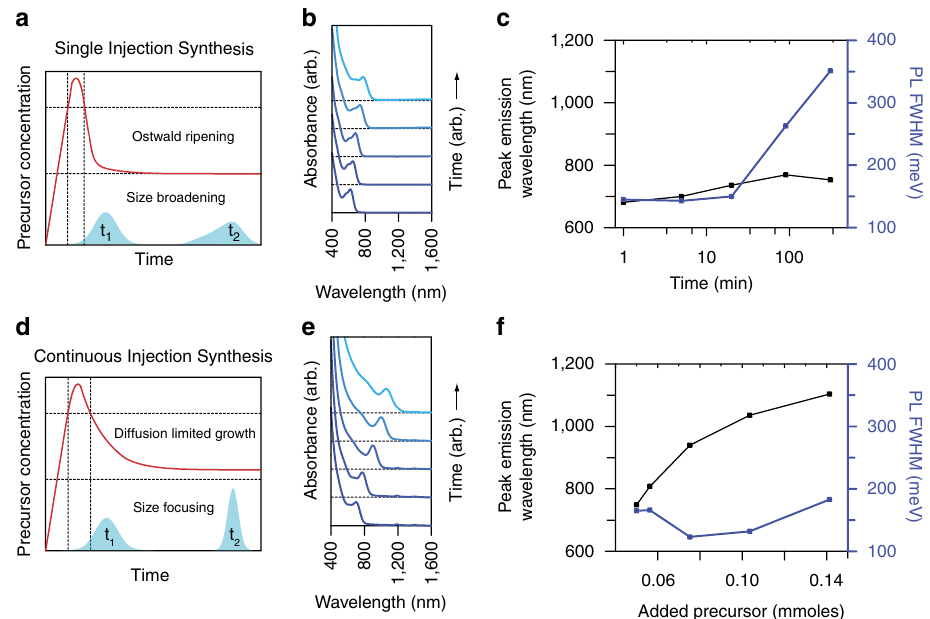
Figure 1 | Growth mechanisms for InAs QDs. Schematic representation of the temporal evolution of precursor concentration during ( a ) a typical hot- injection synthesis of InAs QDs and ( d ) during a combination of hot and continuous injection. As a single injection supplies all precursor material at the beginning of the reaction, growth is primarily dominated by interparticle ripening, leading to a small overall growth of nanocrystals that is correlated with a broadening of the size distribution at long time scales ( b , c ). If a single injection, however, is followed by a slow, continuous supply of precursor material, the system can be maintained in a prolonged size-focusing regime, giving access to large nanocrystals with narrow size distributions ( e , f